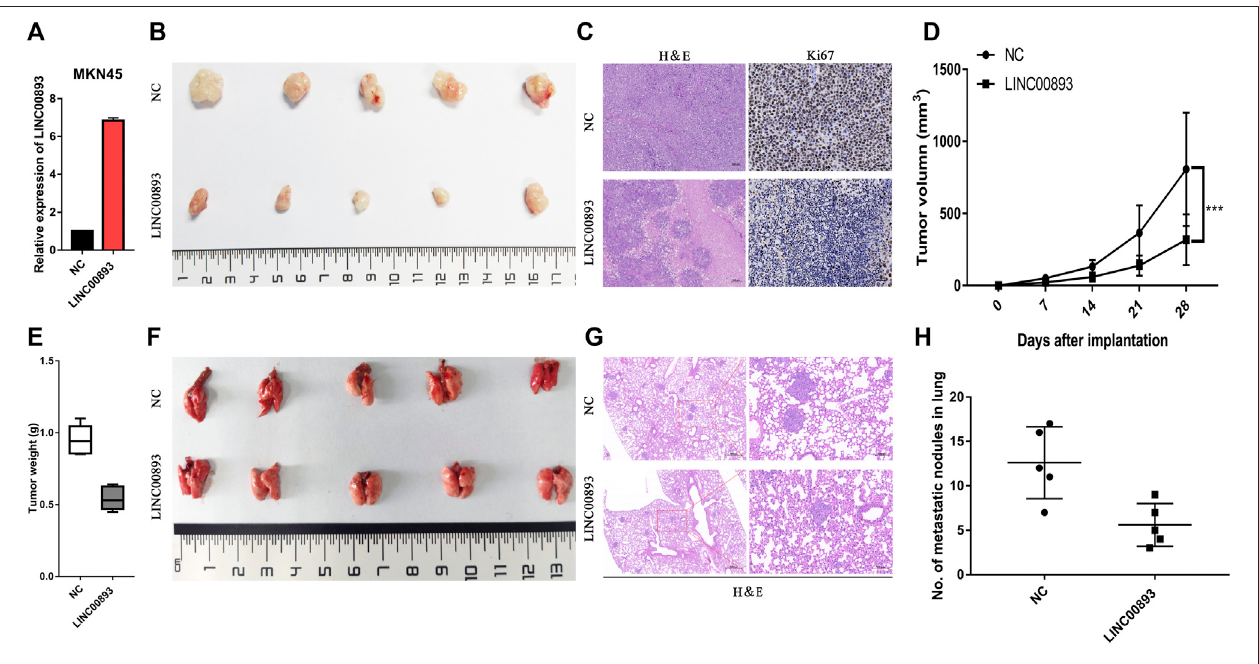
FIGURE 4 | LINC00893 inhibits the growth and metastasis of gastric cancer cells in vivo (A) LINC00893 stable-overexpressed MKN45 cells was constructed (B) Representative imagesof subcutaneous xenograft tumors from the two group (C) Representative images of H&E and IHC with anti-Ki67 of the subcutaneous xenograft tumors (D) Quanti fi cation of tumor volumes in NC or LINC00893 overexpressed MKN45 cells in xenograft mouse models (E) Tumor weights were analyzed (F) RepresentativeimagesoflungmetastasisofLINC00893overexpressiongroupsandcontrolgroup (G) Representativehematoxylinandeosin(H&E)stainingresults of corresponding lung metastatic nodules (H) Statistical analysis of numbers of metastatic nodules in the lung. *** p < 0.001.